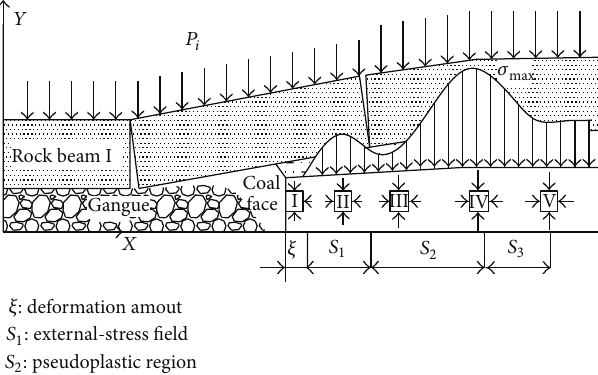
Figure 8: The mechanical model with coal body being